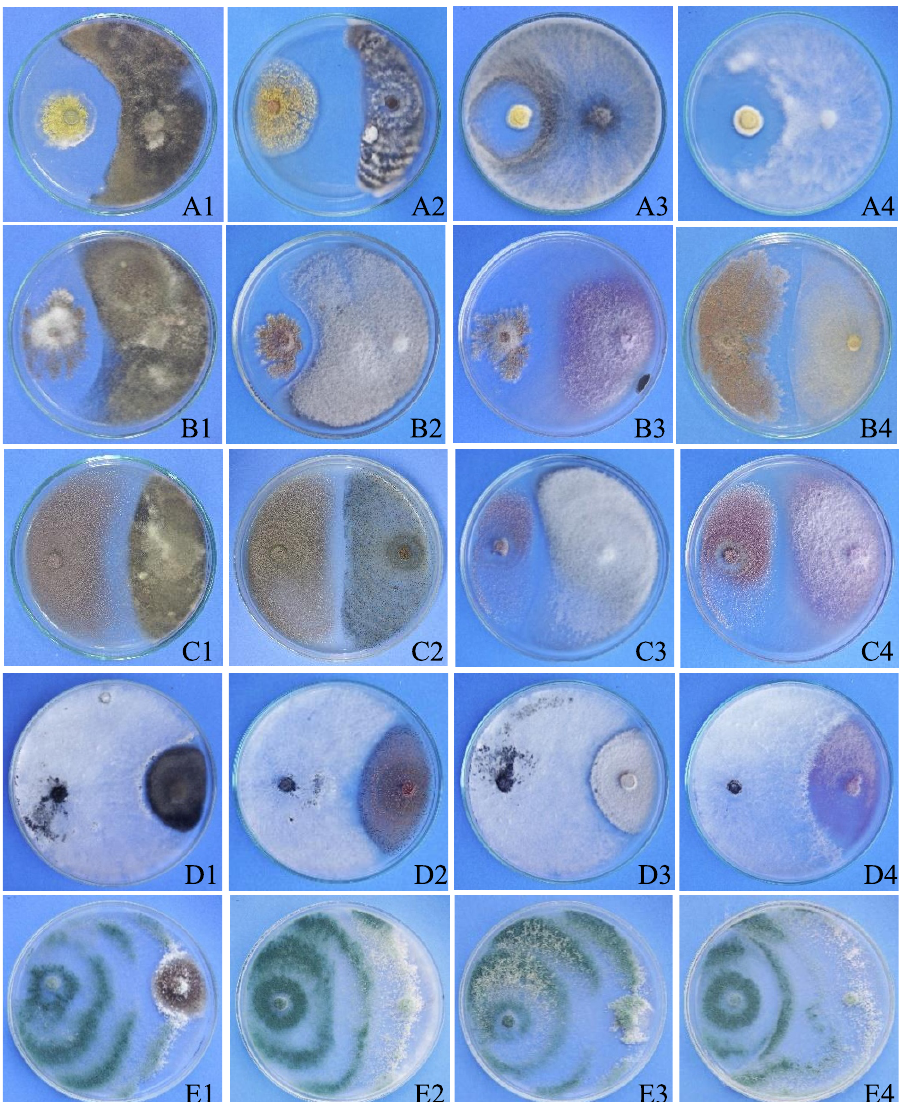
Fig. 1. Antagonistic effects of marine-derived fungi (left) on plant pathogenic fungi (right) in dual cultures on PDA plates. A. Talaromyces tratensis KUFA0091 vs A . brassicicola (A1), B . oryzae (A2), L. theobromae (A3), P. palmivora (A4) B. Emericella rugulosa KUFA1002 vs A . brassicicola (B1), C . gloeosporiodes (B2), F. oxysporum (B3), P . oryzae (B4) C. Neocosmospora vasinfecta var. vasinfecta KUFA1004 vs A . brassicicola (C1), C. capsici (C2), C . gloeosporiodes (C3), F. oxysporum (C4) D. Arthrinium xenocordella KUFA1018 vs A . brassicicola (D1), C. capsici (D2), C . gloeosporiodes (D3), F . oxysporum (D4) E. Trichoderma harzianum KUFA0677 vs A . brassicicola (E1), P. palmivora (E2), P. oryzae (E3), R. oryzae